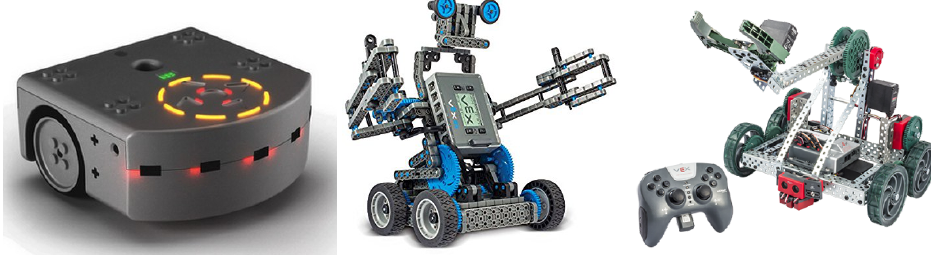
Figure 2. Robots Thymio, VEX IQ and VEX